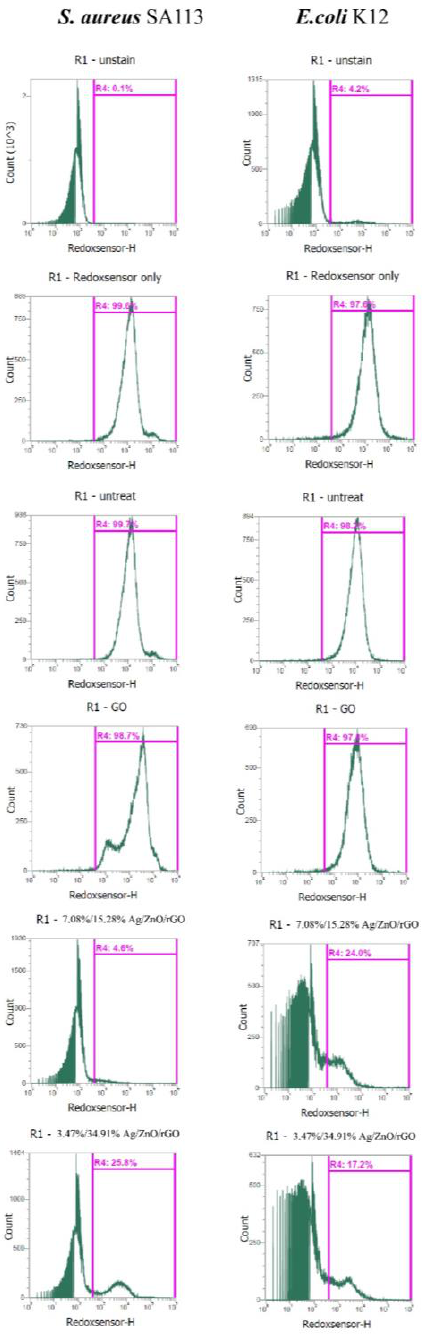
Figure 7. Analysis of RedoxSensor staining intensity in E. coli K12 and S. aureus SA113 strains. These two strains were grown in MHB supplemented with 100 ppm of 3.47 / 34.91% and 7.08 / 15.28% Ag / ZnO / rGO composites for 3 h, and the cells were then treated with RedoxSensor (green). The X-axis represents the RedoxSensor intensity in arbitrary units (a.u.) and the Y-axis represents the cell counts as measured by flow cytometry. PBS-only and unstained cells were used as the controls. RedoxSensor fluorescence is presented in a false green color. Data are representative of two separate experiments. PBS bu ff er only: addition of only PBS bu ff er (no cells or fluorescent dyes); unstained: untreated bacterial cells that did not stain with fluorescent dyes; PI only: untreated bacterial cells stained with PI dye only without Redox dye; Redox only: bacterial cells stained with Redox dye but not PI dye; Ag / ZnO / rGO: bacterial cells stained with both PI and Redox dyes at 100 ppm Ag / ZnO / rGO. All parameters were collected as logarithmic